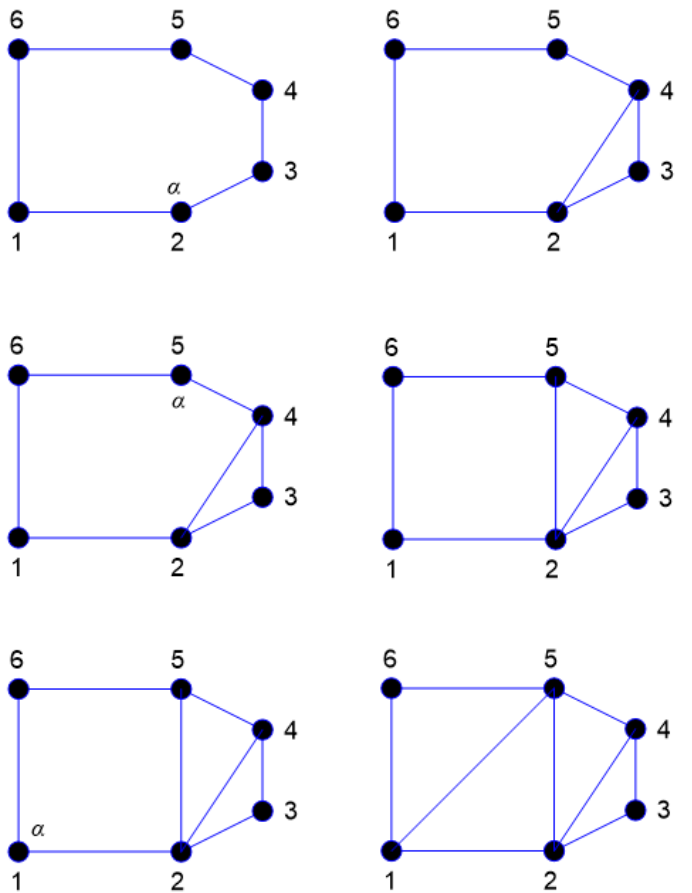
Figure 2. Division of a polygon based on the proposed dichotomy method.